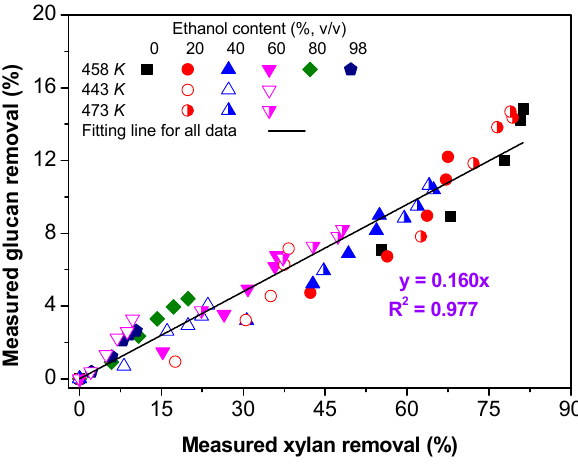
Figure 6. The relationship between measured xylan and glucan removal during EACO pretreatments.